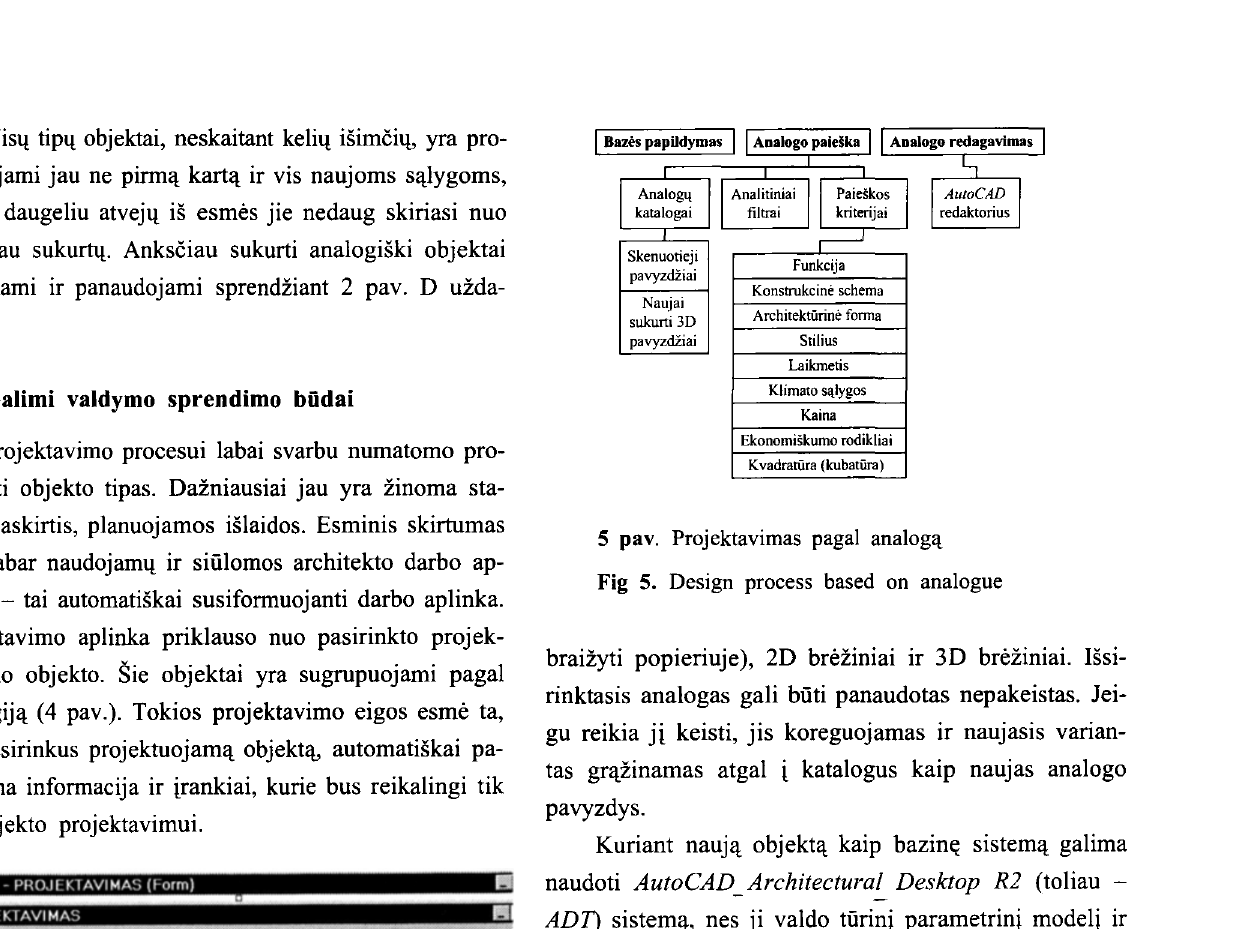
Fig 4. System control Pasirinkus objekt'l galimi du is principo skirtingi projektavimo biidai: ieskoti tinkamiausio analogo ir ji redaguoti pagal nauj'l situacij'l arba kurti visiskai nauj'l objekt'l.